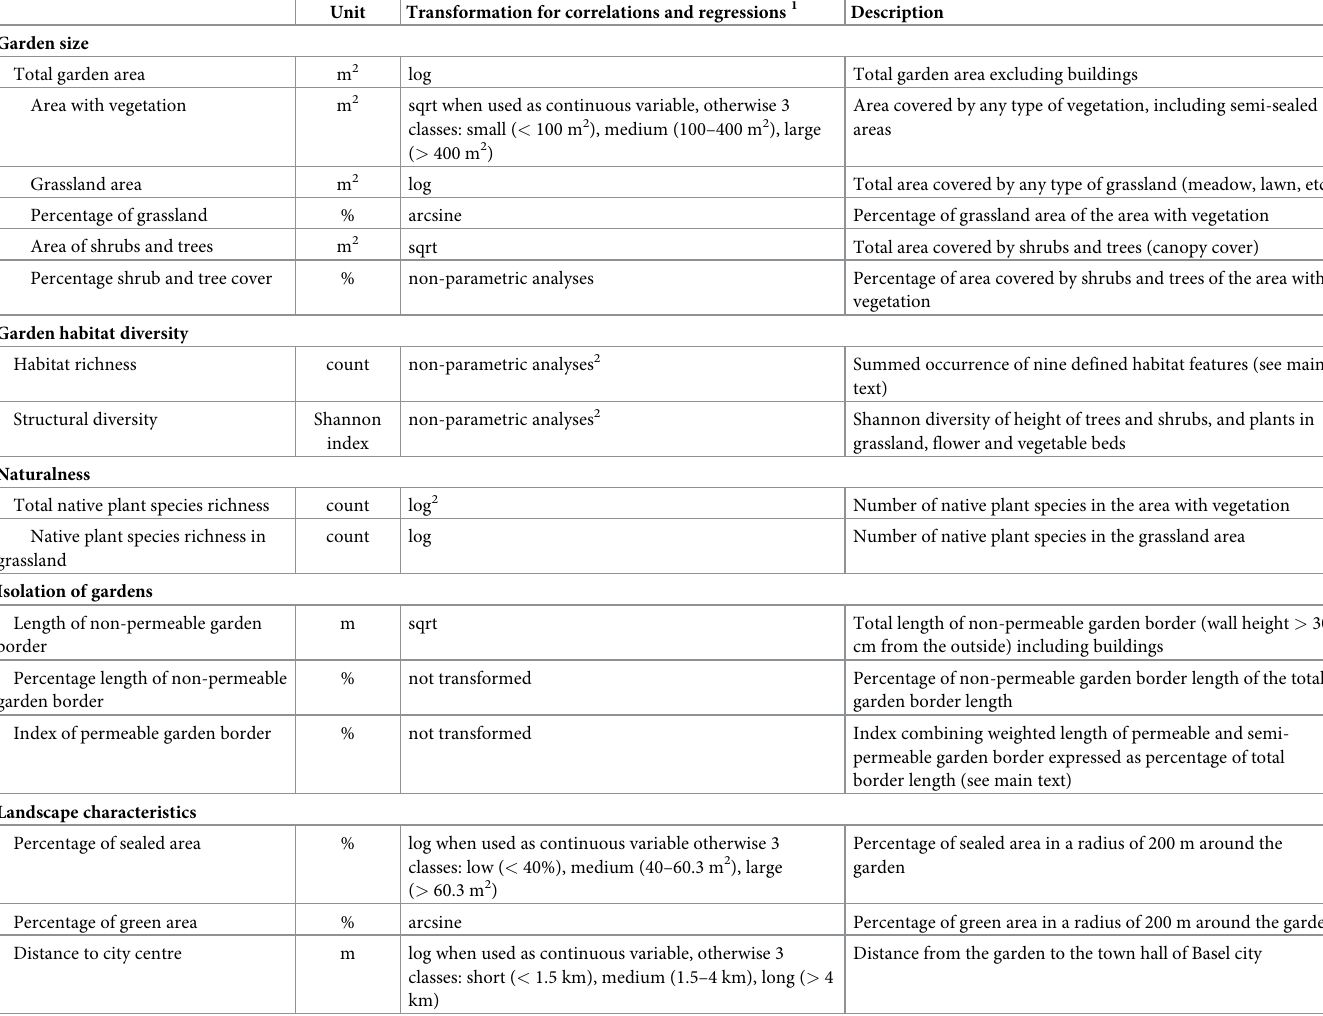
Table 1. Definitions of local garden and landscape characteristics and transformation of data in the analyses and transformations used in correlation and regres- sion